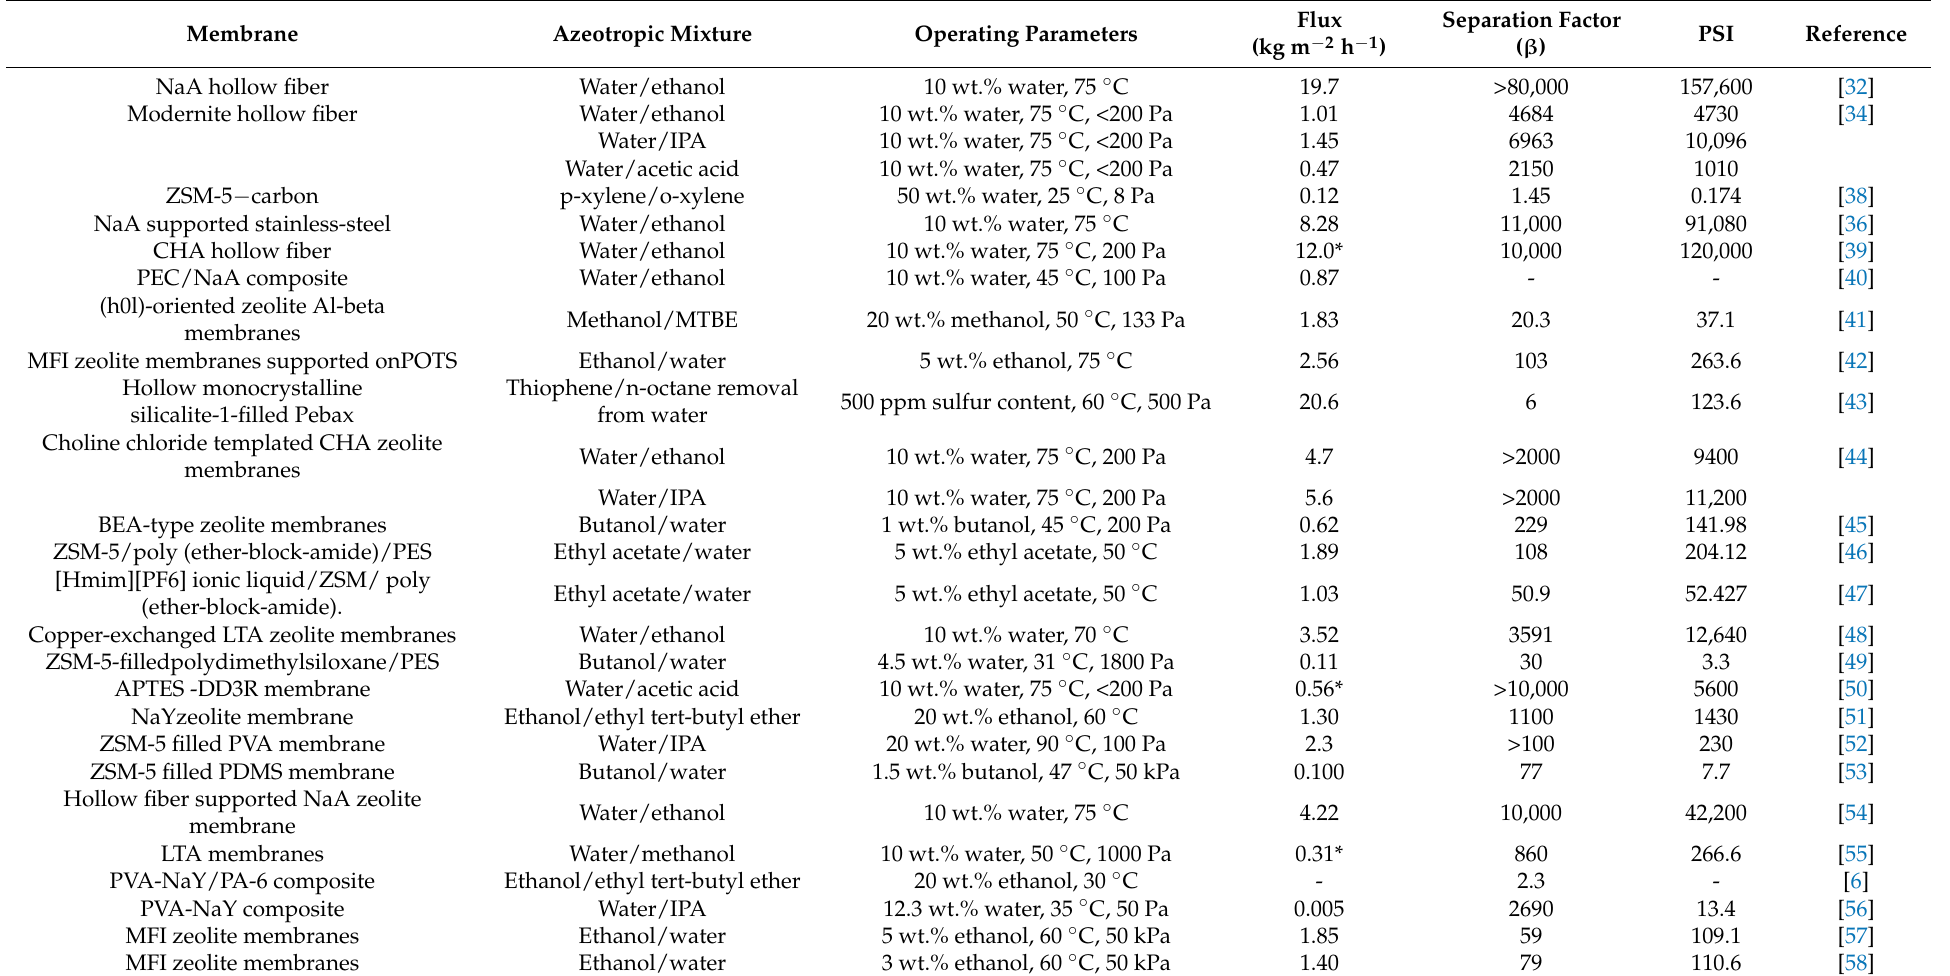
Table 2. Recent studies in applying zeolite-based composites for separation of azeotropic